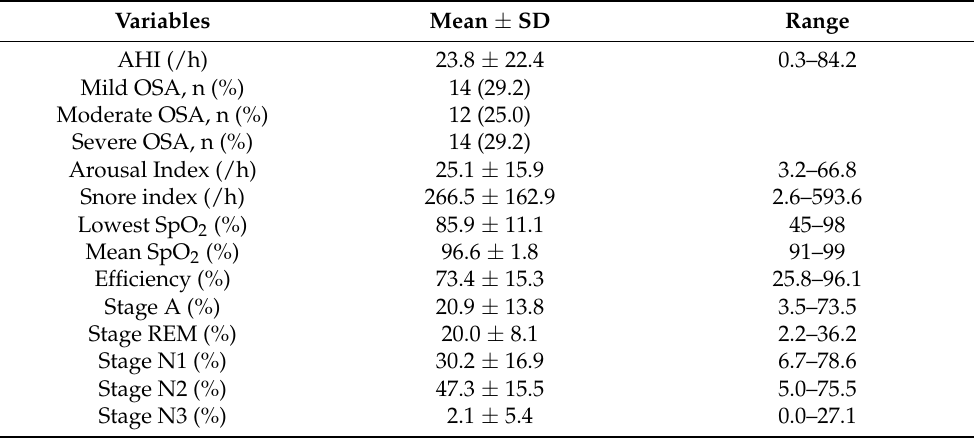
Table 2. Polysomnographic results of the study participants.